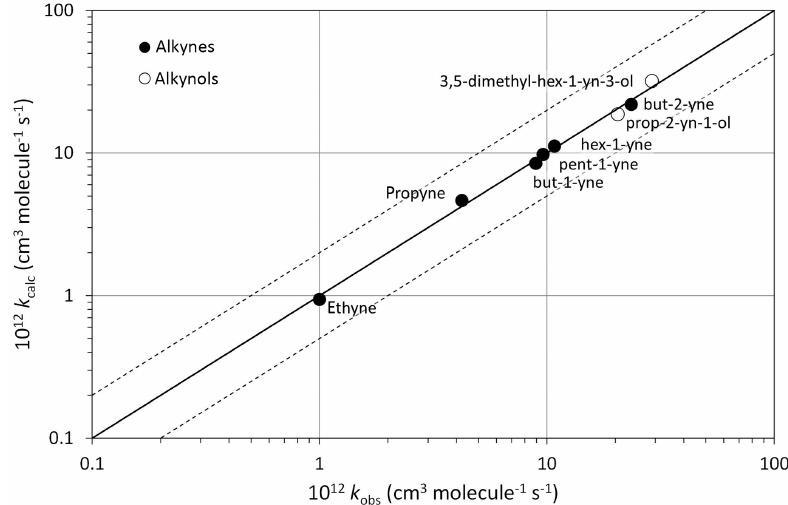
Figure 8. A log–log correlation of k calc and k obs at 298K for alkynes and alkynols. The broken lines show the factor of 2 range.